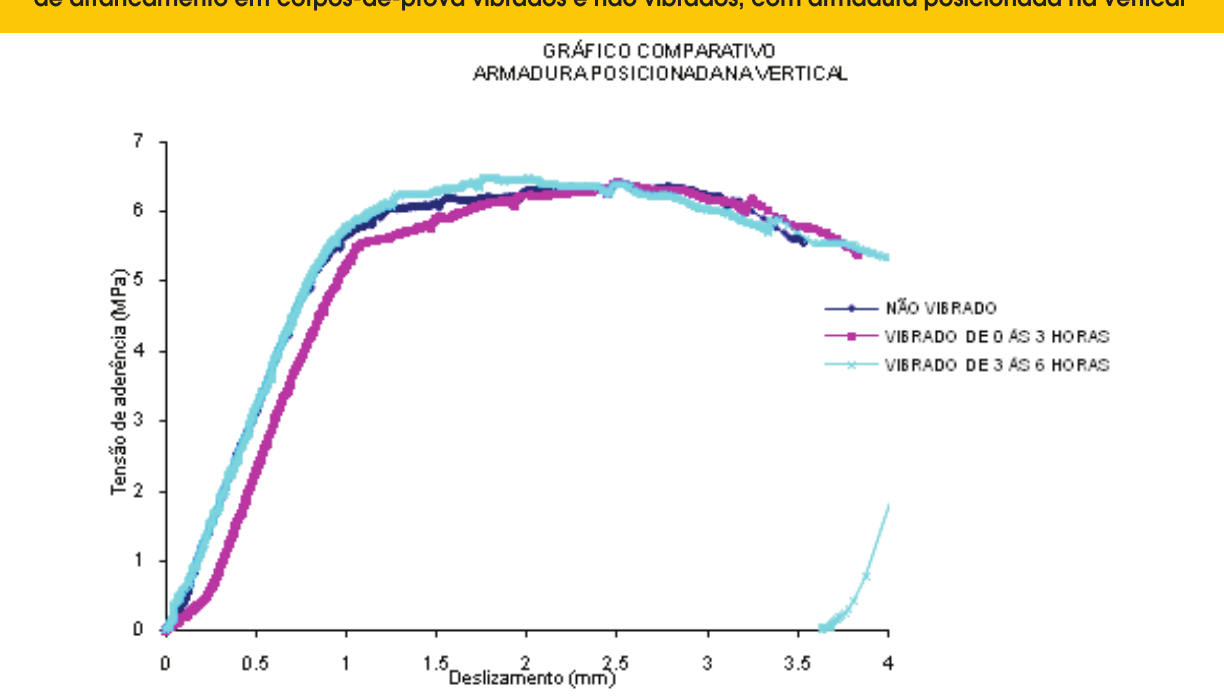
Figura 4 – Gráfico comparativo da evolução da tensão de aderência e deslizamentos da barra durante ensaios de arrancamento em corpos-de-prova vibrados e não vibrados, com armadura posicionada na